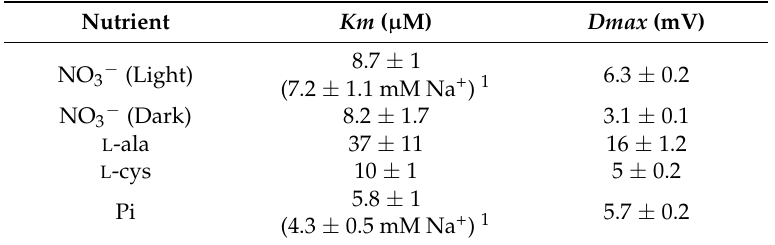
Table 2. NO 3 − , amino acids and Pi kinetics parameters in mesophyll leaf cells of P. oceanica .